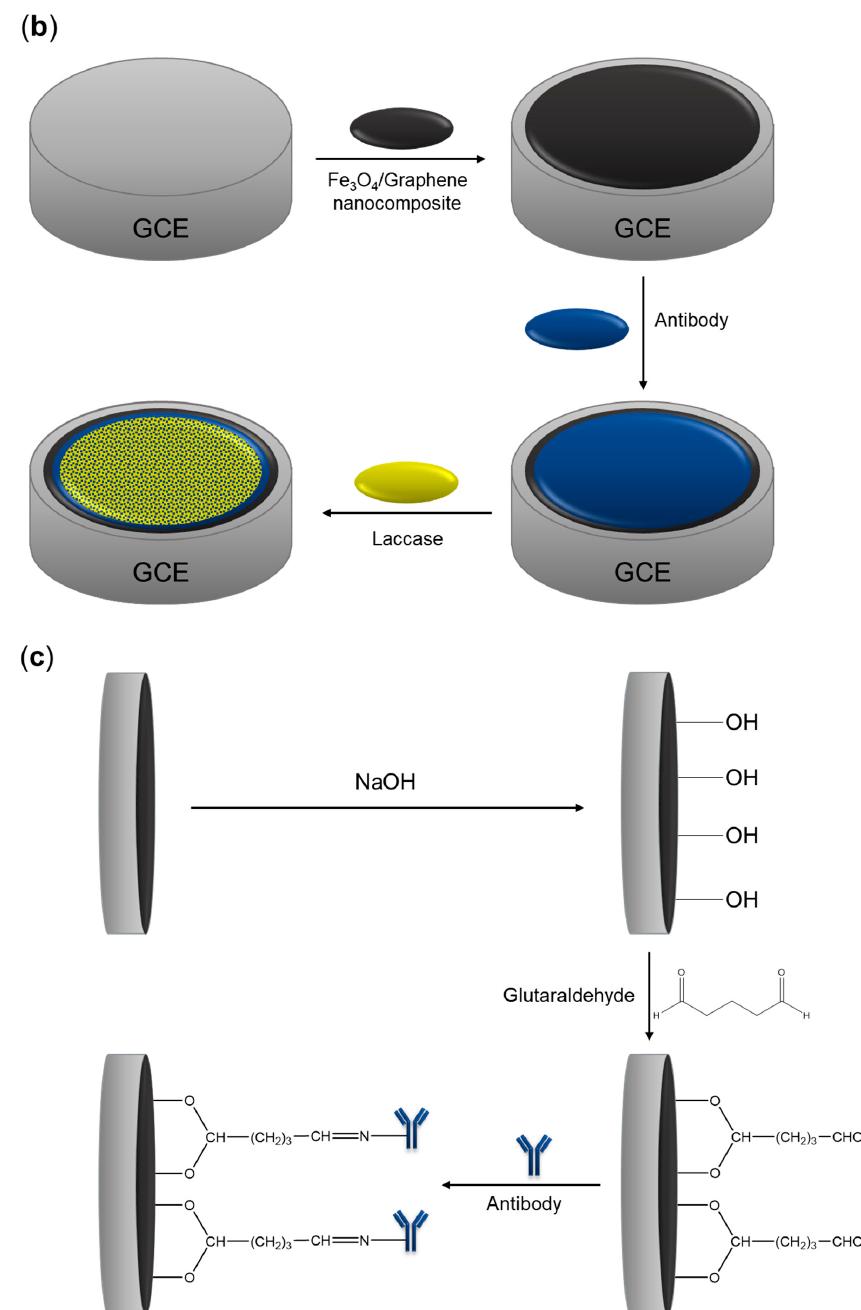
Figure 2. ( a ) Schematic representation of the biosensor’s working principle; ( b ) schematic